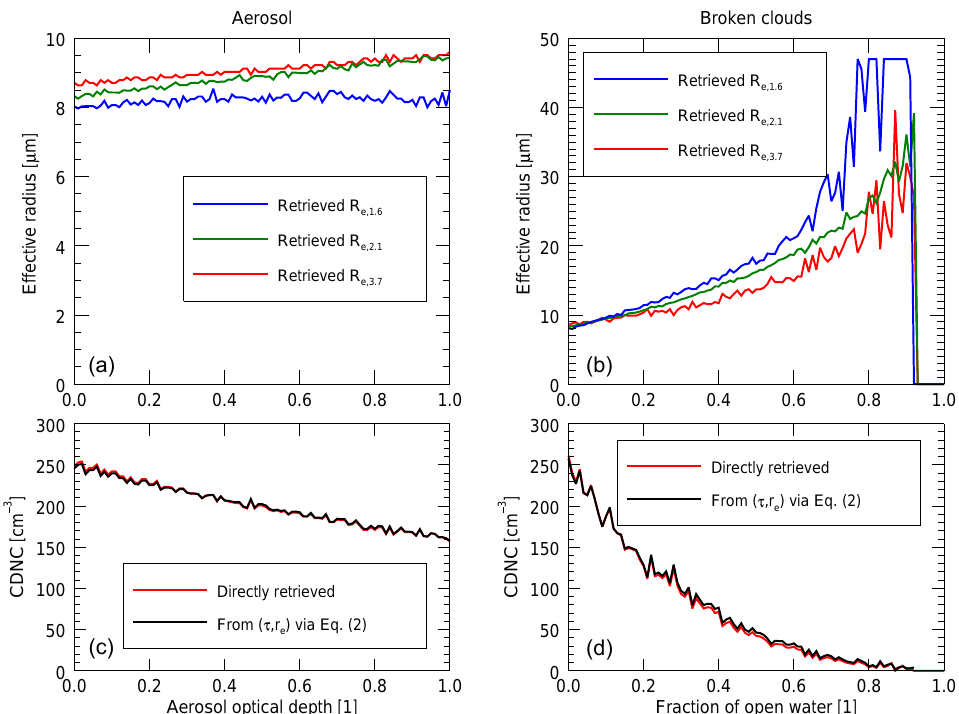
Figure 3. Simulated retrieval for effective radius (a, b) and CDNC (c, d) for the aerosol-affected (a, c) and partly cloudy reflectances (b, d) , respectively, shown in Fig. 1. CDNC retrievals tagged “directly retrieved” are performed using the green meshes in Fig. 1, rightmost panel, whereas CDNC retrievals marked “from Eq. (2)” are derived by first using the 3.7µm optical depth and effective radius retrieval and subsequently converting it to CDNC using Eq. (2). This latter approach is similar to the actual way we retrieve CDNC from MODIS cloud optical properties. The “Fraction of open water” refers to the fraction of an inhomogeneous Level-2 MODIS pixel that is not covered by